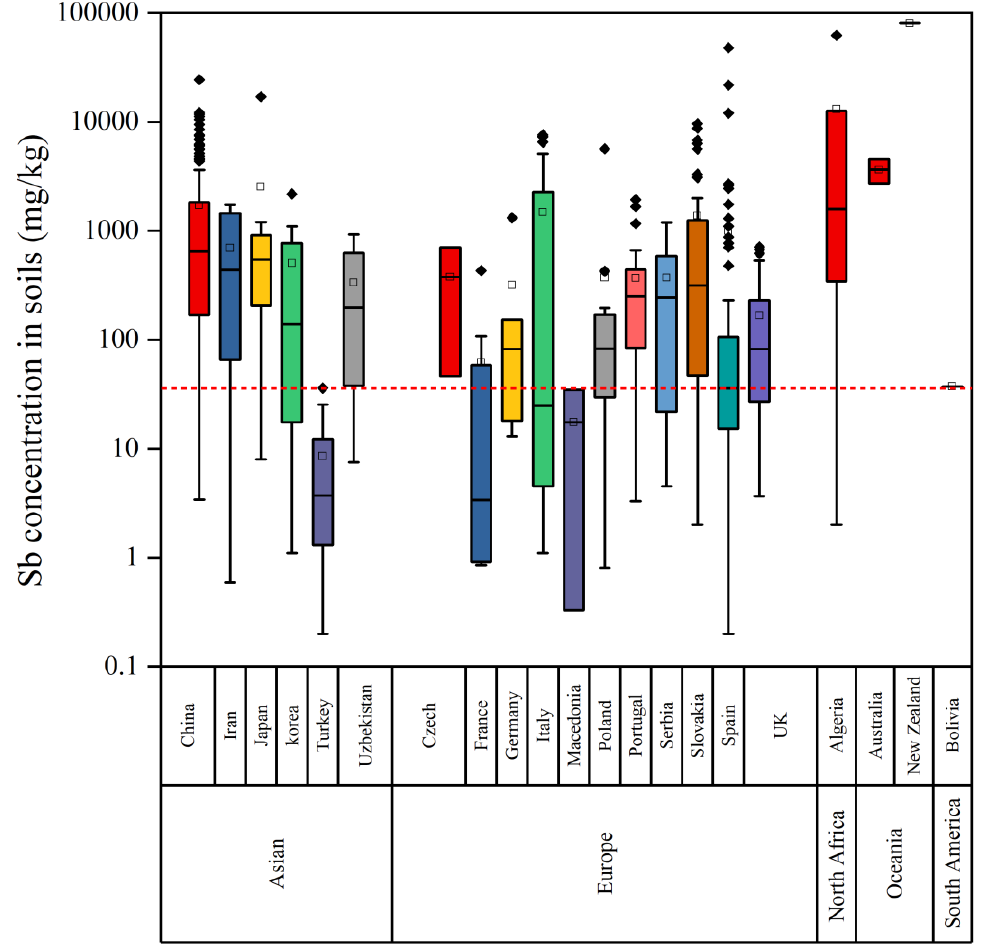
Figure 3. Global comparison between the average concentrations of Sb reported in soils related to mining/smelting activities. The red dotted line represents the maximum permissible limit (36 mg/kg) recommended by WHO.